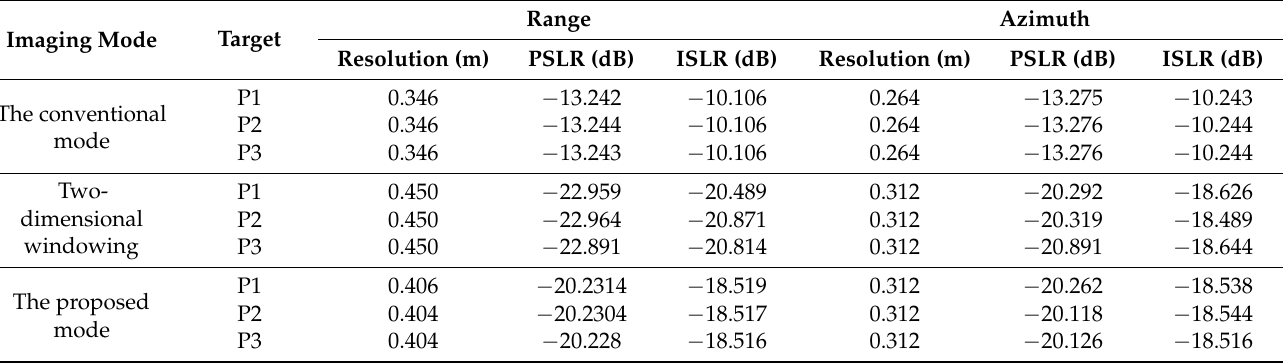
Table 2. Measured focusing parameter of imaging results on the designed